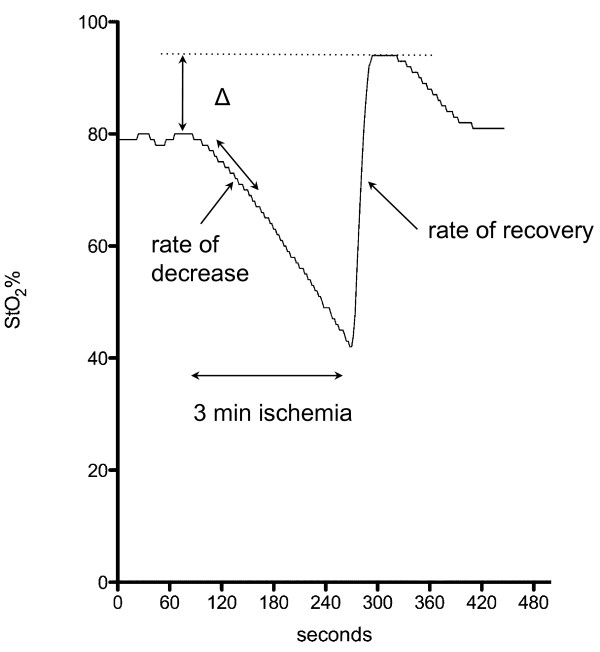
Focus on the reaction of a StO2-trace after a vascular occlusion test. Δ: delta, difference between StO2max and StO2 baseline; rate of decrease (first 25%); rate of recovery.